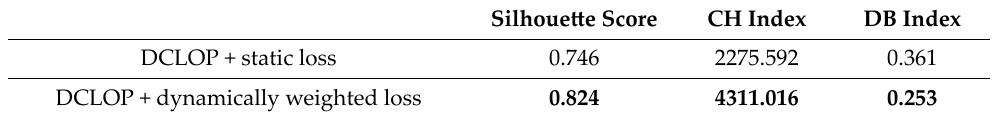
Table 3. Deep clustering evaluation.